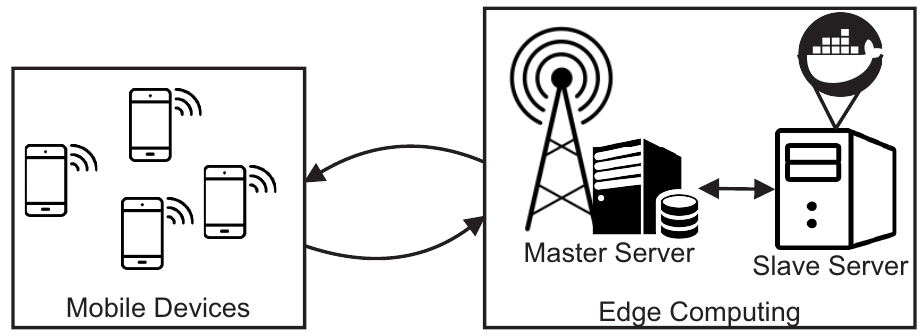
Figure 1. MEC Architecture Base Adopted in Performance Evaluation. (adapted from [35,36]).